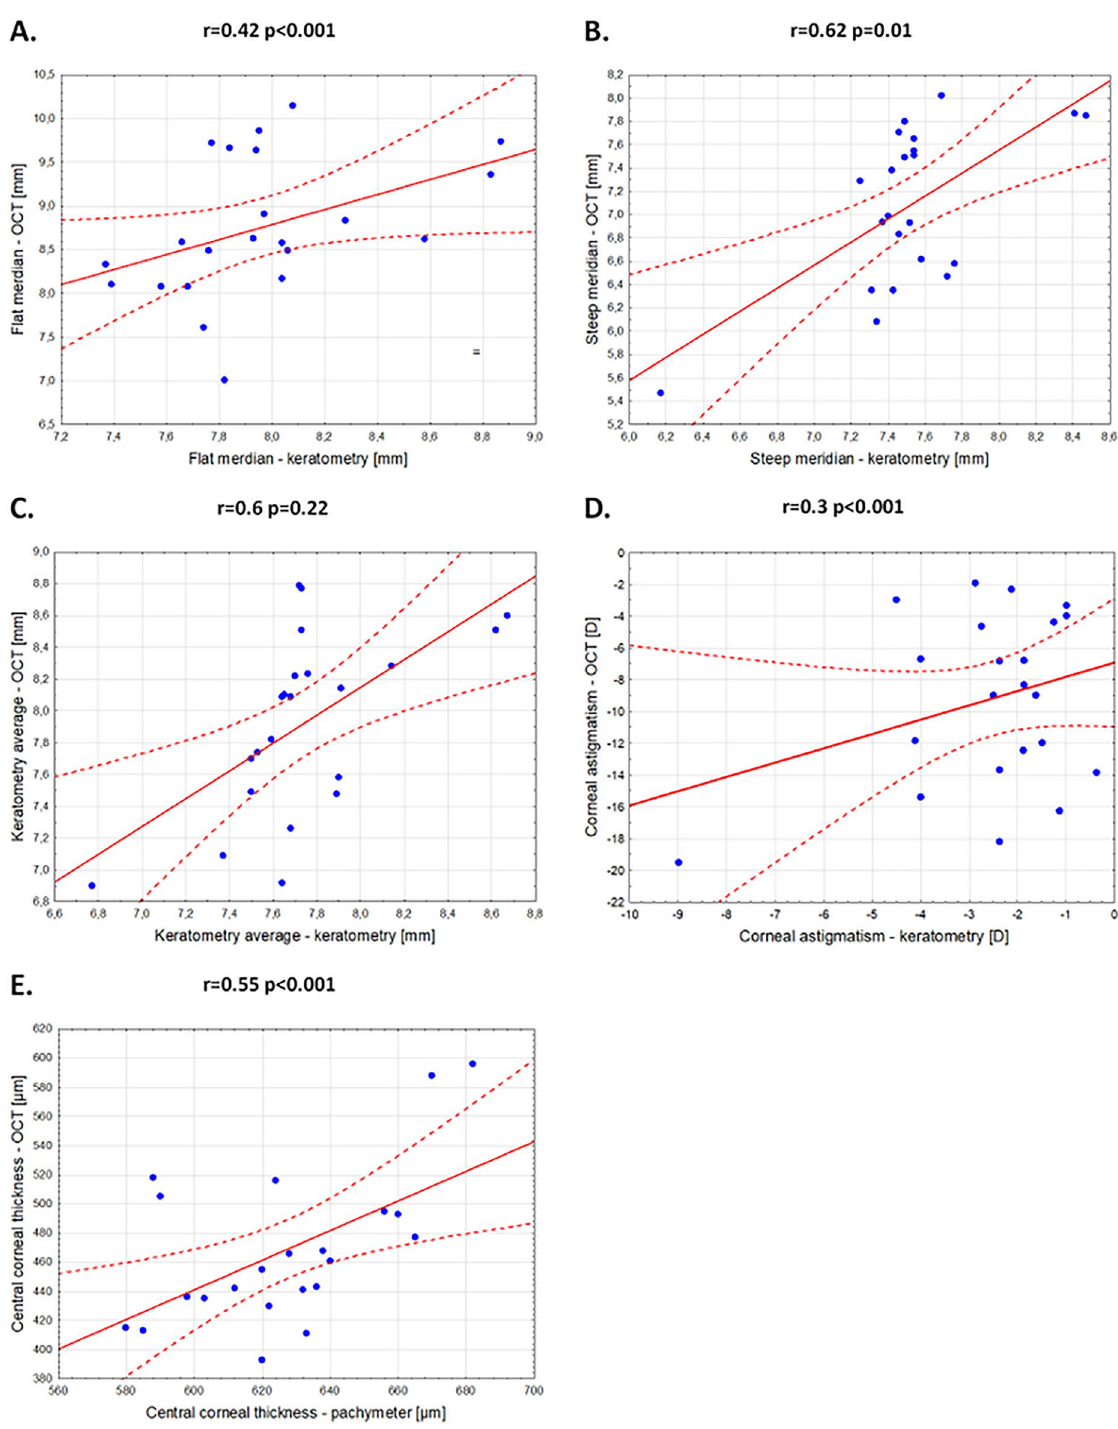
Figure 2. Pearson correlation plots between the anterior surface parameters of the cornea and its thickness measured on the deceased with corneal measurements made after its excision from the eye. ( A ) flat meridian; ( B ) steep meridian; ( C ) average keratometry; ( D ) corneal astigmatism; ( E ) central corneal